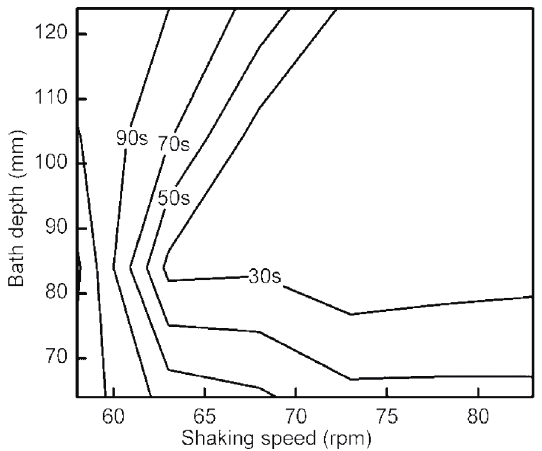
Fig. 8: Contour plot of mixing time distribution at different shaking speeds and bath heights at a = 30 mm